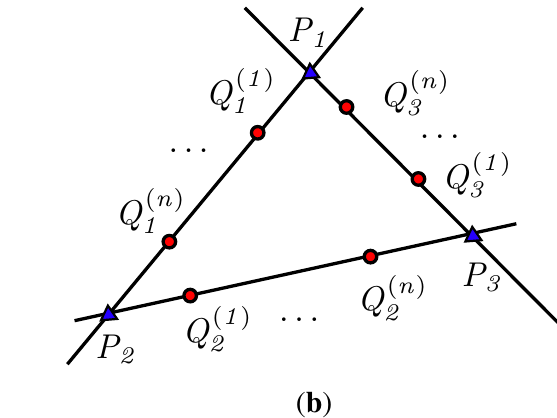
Figure 2. Points to calculate the characteristics number when ( a ) r = 2 and ( b ) r = 3